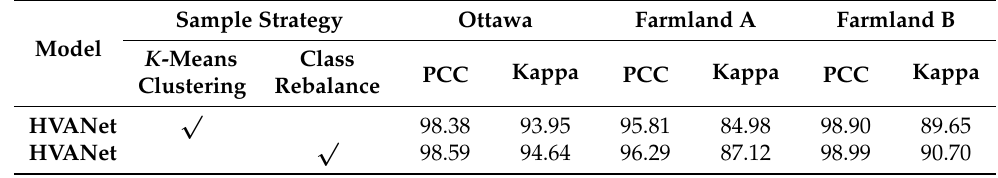
Table 4. Ablation study results of the proposed HVANet on class rebalance strategy.